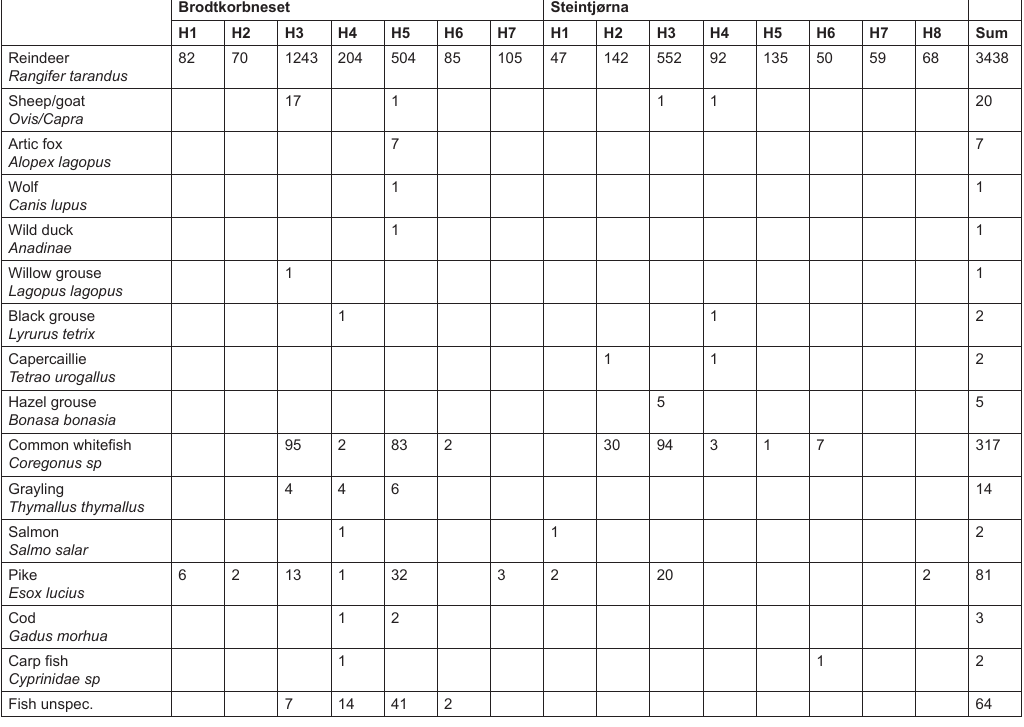
Table 4. Number of identified bone fragment per species in the different hearths.